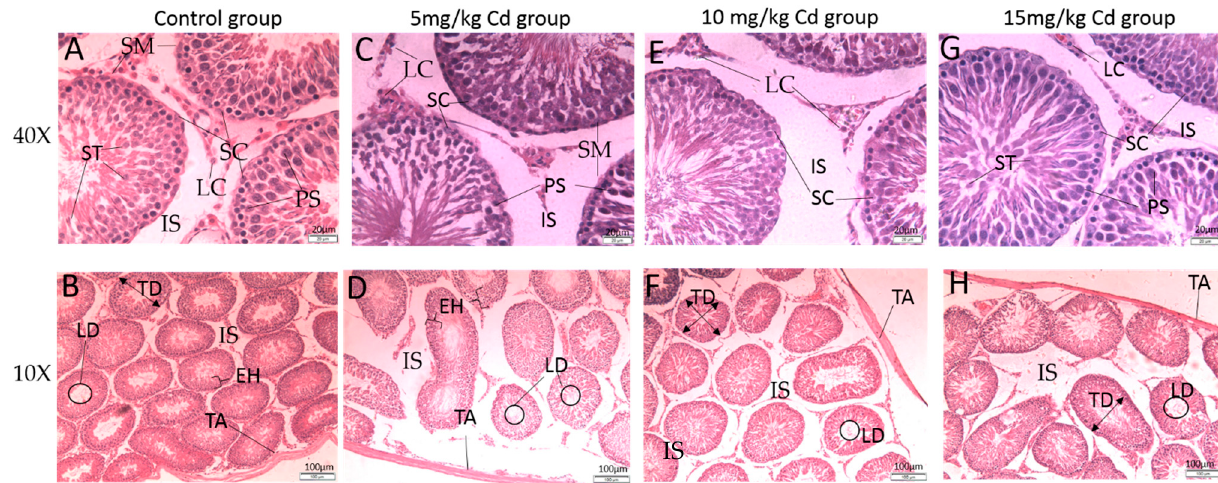
Figure 2. Microphotograph of testicular tissue (seminiferous tubules). ( A , B ) The control group showed normal seminiferous tubules with a lumen filled with sperm. The interstitial space revealed normal Leydig cells. ( C , D ) The 5 mg Cd/kg treatment group showed a decrease in epithelial height and a marked increase in interstitial space. The ( E , F ) 10 mg Cd/kg and ( G , H ) 15 mg Cd/kg treatment groups revealed prominent damage. In particular, the number of Leydig cells in interstitial space are decreased and spermatogenesis in epithelium appeared to be disrupted. (LC: Leydig cells, SM; smooth muscle, ST: spermatids, PS: primary spermatocytes, IS interstitial space, SC: Sertoli cells, LD: (lumen diameter) tubular lumen, EH: epithelial height, TD: diameter of seminiferous tubules TA: tunica albuginea.